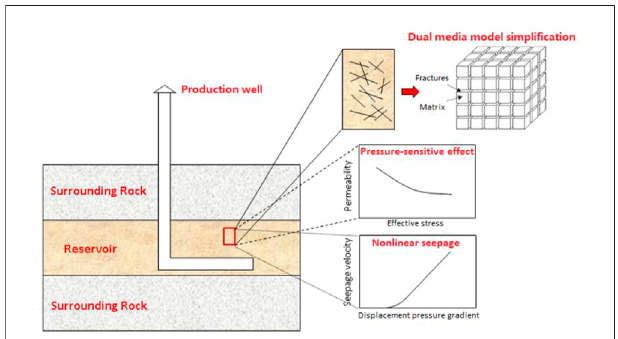
FIGURE 2 | The matrix/fracture transfer fl ow in the fracturing zone of tight